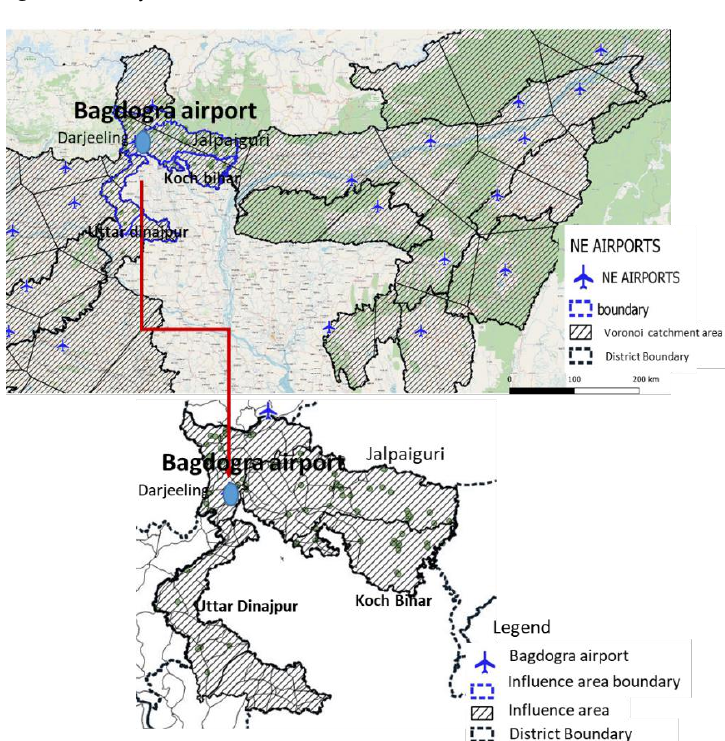
Figure 4. Delineation of the Study